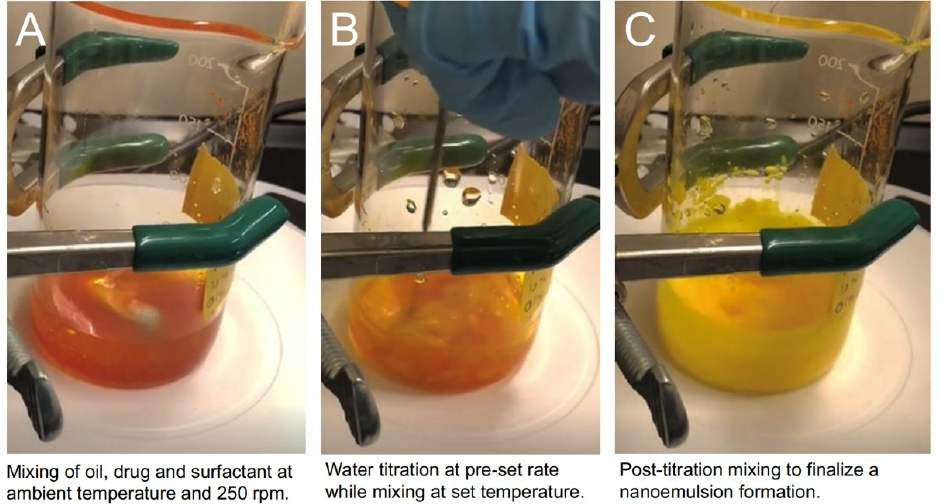
Figure 2. Manufacturing of nanoemulsions using the CPI low-energy emulsification method: ( A ) Pre-titration: mixing oil, surfactant, and drug; ( B ) water (aqueous phase) titration. As water is added, a viscous liquid crystalline gel is formed, requiring manual stirring; ( C ) Post-titration: curcumin loaded nanoemulsion is formed after continued stirring for 60–90 min.